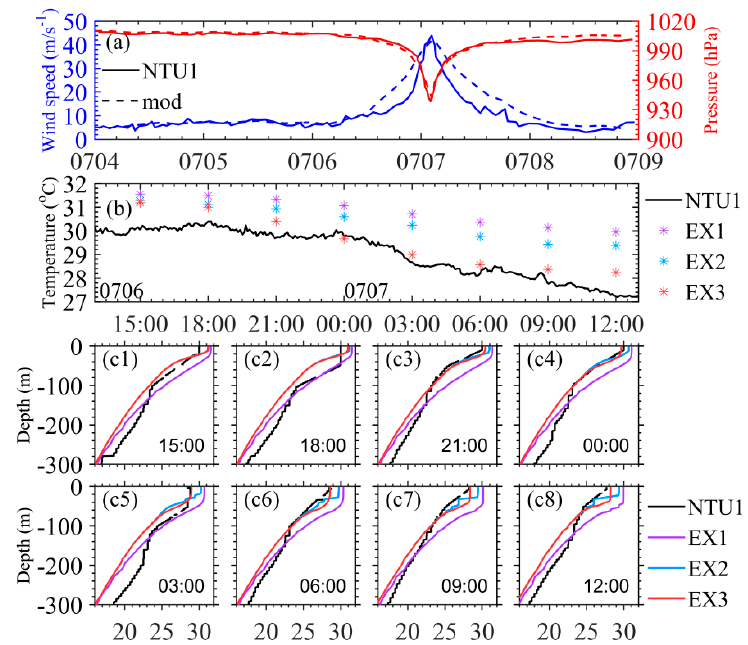
Figure 6. Comparisons between the model data and the NTU1 data. ( a ) Wind speed and pressure. ( b ) Upper 25 m-averaged temperature, the time axis indicates the model output time. ( c ) Temperature profiles at the corresponding moment ticked in b. Remote Sens. 2020 , 12 , x FOR PEER REVIEW 16 of 27